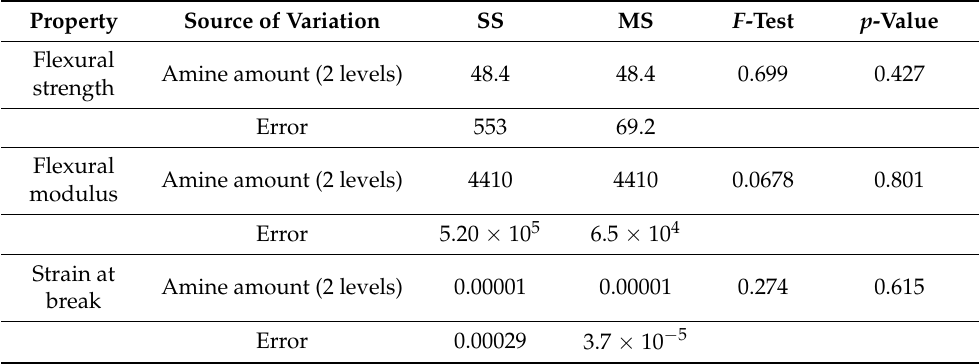
Table 8. ANOVA parameters—effect of the amount of amine on the mechanical properties, neglecting samples with commercial